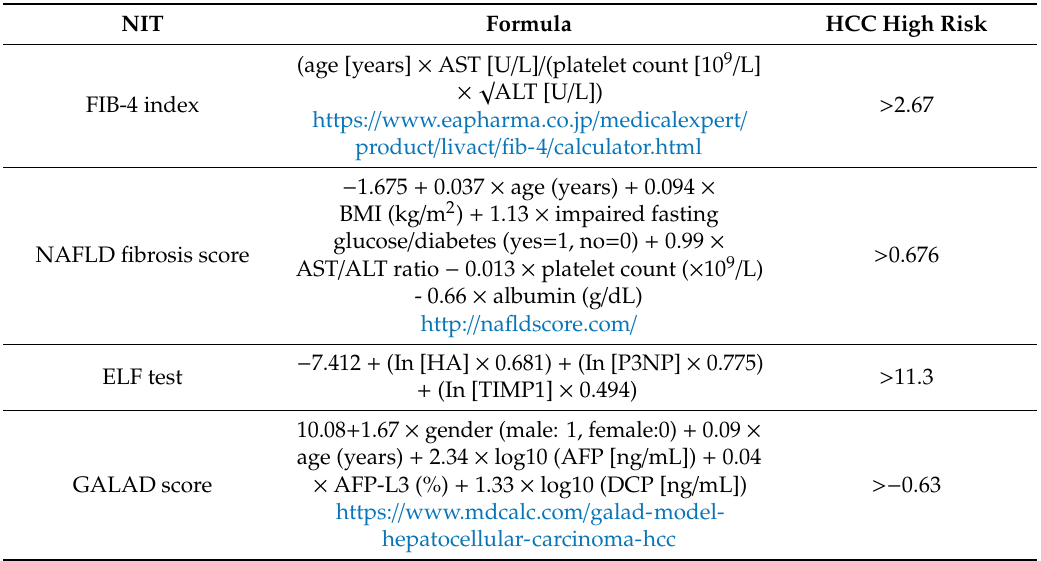
FIB-4: fibrosis-4, AST: aspartate aminotransferase, ALT: alanine aminotransferase, BMI: body mass index, HA: hyaluronic acid, P3NP: aminoterminal propeptide of type 3 procollagen. TIMP-1: tissue inhibitor of matrix metalloproteinase type 1, ELF: enhanced liver fibrosis, AFP: α fetoprotein, DCP: des- γ -carboxy